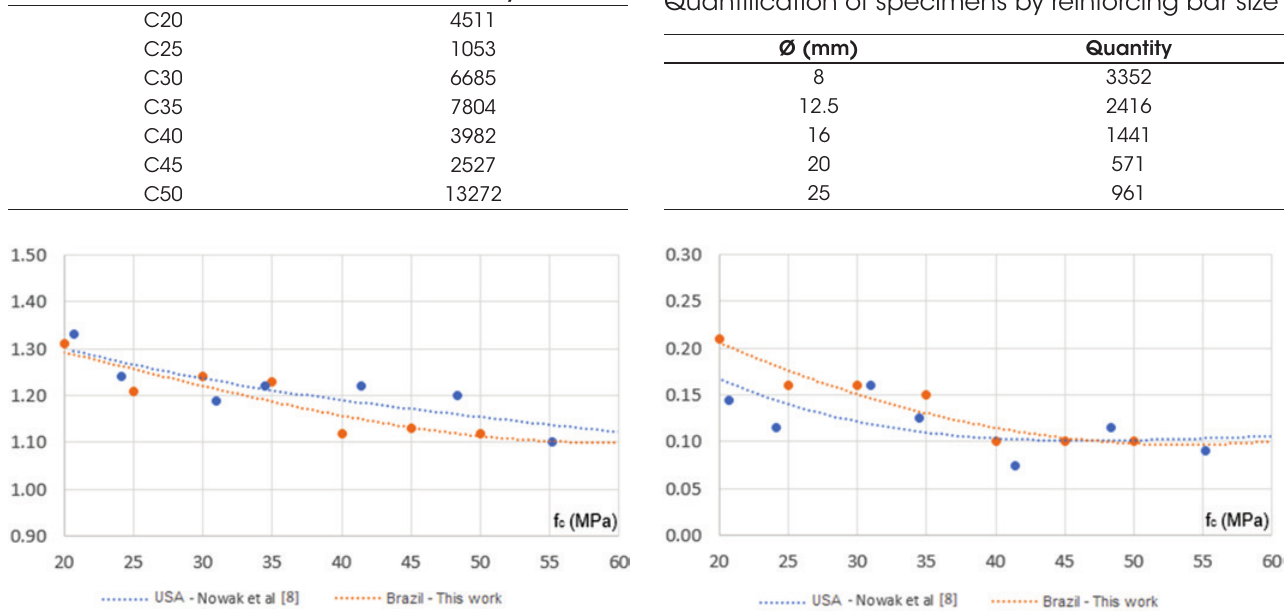
a µ b C.V. Recommended parameters for the probability distribution functions of the variable f